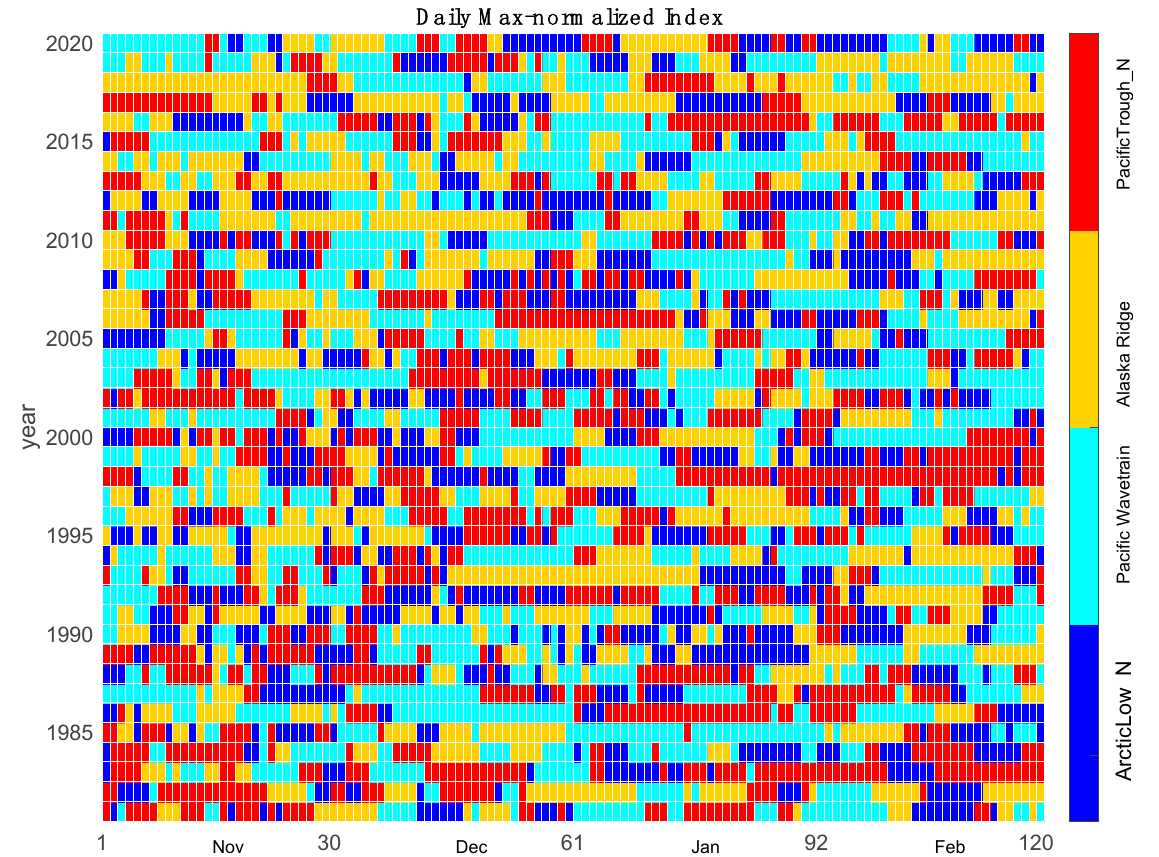
Figure 3. Days when a given index ranked top among the four patterns (color-coded) for the winter months (November to February) during 1981–2020. Each index is normalized using its own daily standard deviation computed over the 1981–2010 period.